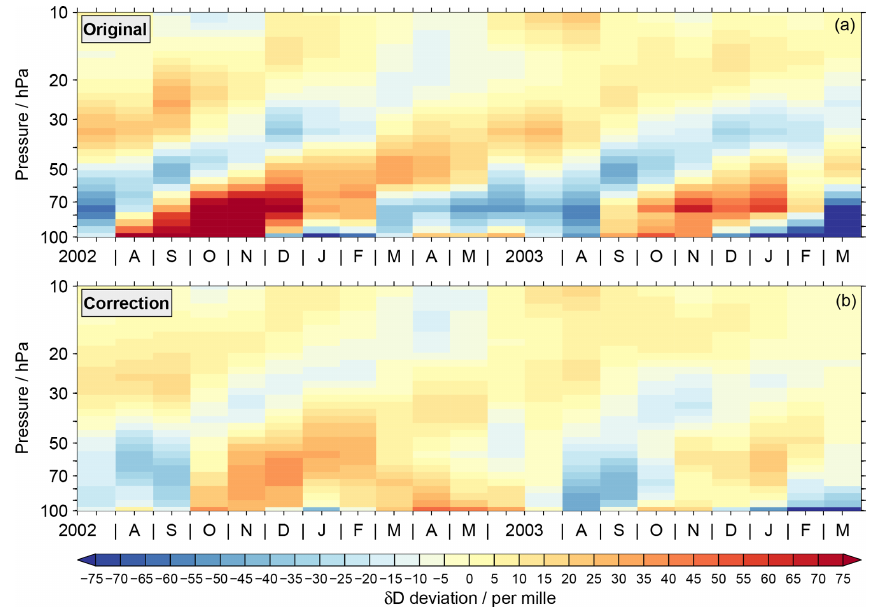
Figure 13. Correction of the MIPAS δ D data with the results from the convolution test shown in the previous figure. Panel (a) shows the original MIPAS time series and panel (b) the corrected version.